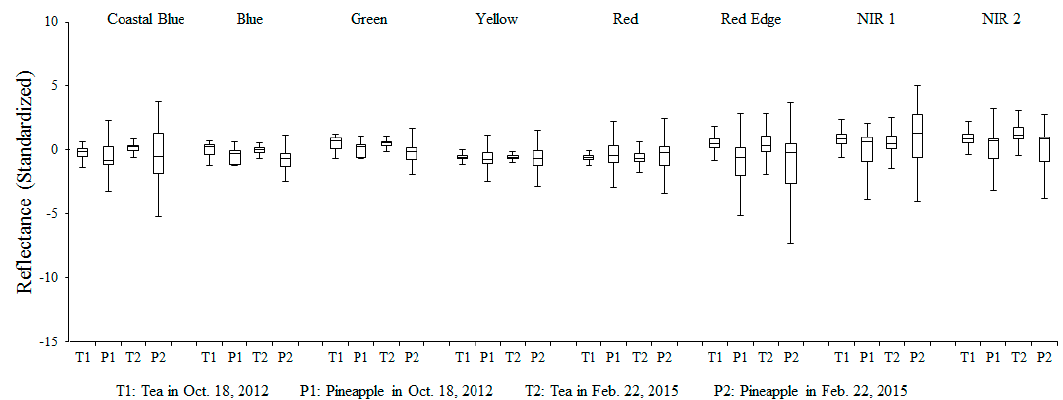
Figure 5. Standardized reflectance of tea crops ( Camellia sinensis (L.) O. Ktze. Var. Sinensis and Camellia sinensis (L.) O. Ktze. Var. Assamica ( Mast. ) Kitam. f. Assamica ) and pineapple in different dates across eight multi-spectral bands.